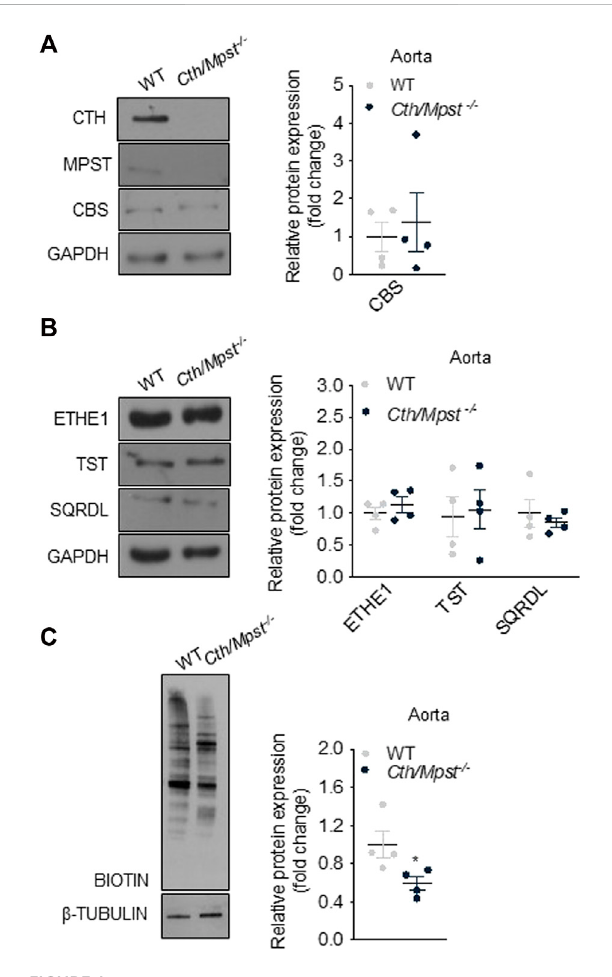
FIGURE 1 Protein expression of H 2 S-generating and degradation enzymes in aorta of Cth/Mpst − / − mice. Proteinswereextracted fromaorta ofWT and double Cth/Mpst knockout mice and subjected to SDS-PAGE and western blotting. Representative western blots and quanti fi cation of (A) MPST, CTH, CBS, (B) ETHE1, TST, SQRDL and (C) protein persul fi dation levels in aorta. Protein expression is presented as ratio over WT group. Data were normalized to GAPDH or β -TUBULIN and presented as means ± S.E.M. N = 4 mice per